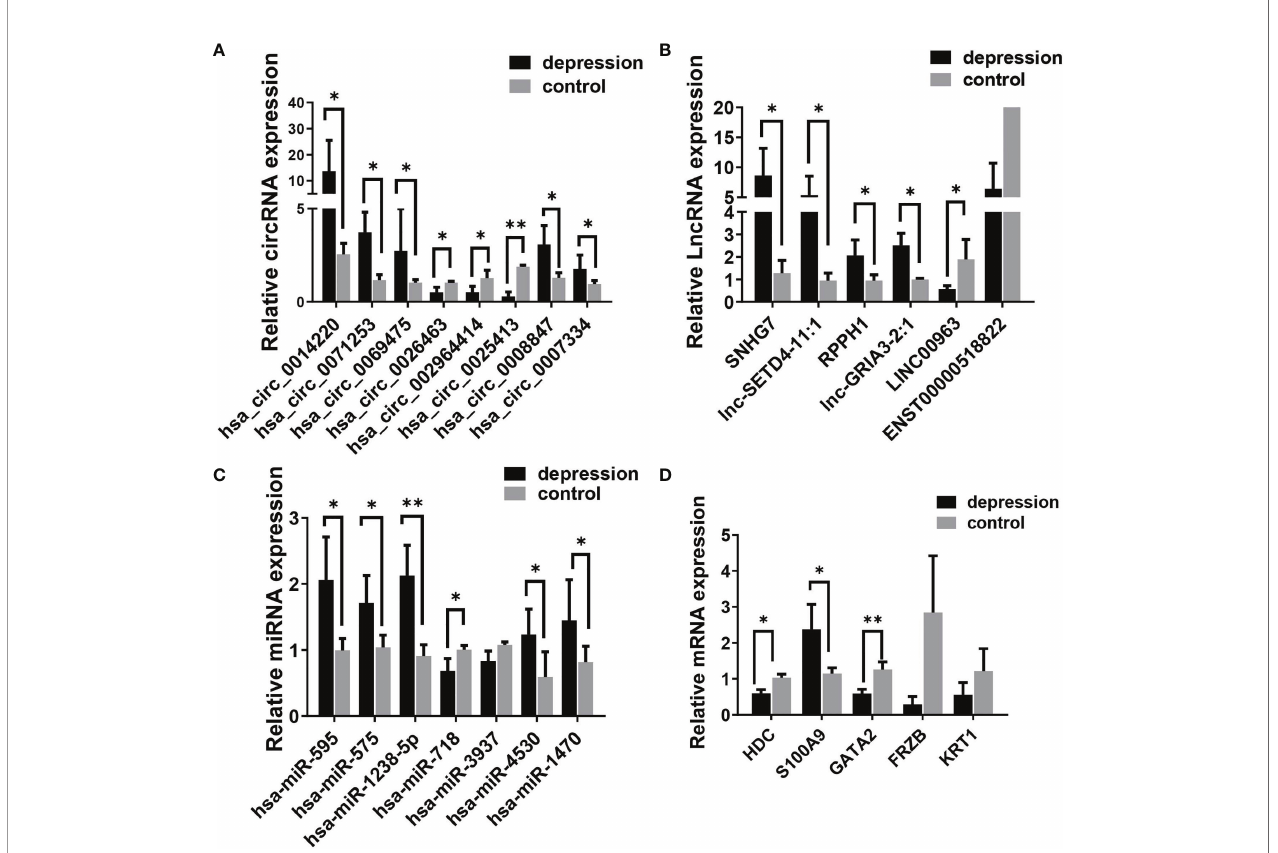
FIGURE 3 | Validation of differentially expressed RNAs selected randomly by quantitative RT-PCR. (A) circRNAs, (B) lncRNAs, (C) miRNAs; and (D) mRNAs. Expression was normalized to U6 for miRNAs and GAPDH for others as internal controls. Data are presented as means ± SD (* p < 0.05, ** p < 0.01) ( n =